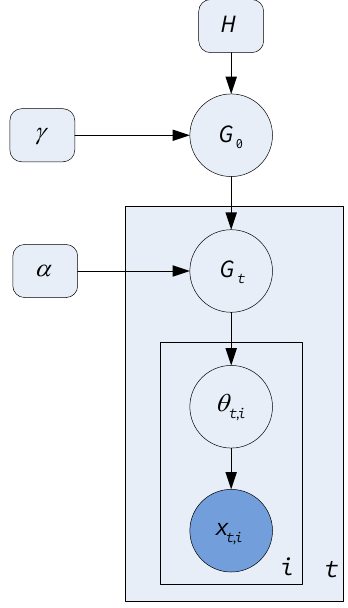
Figure 5. Hierarchical Dirichlet Process